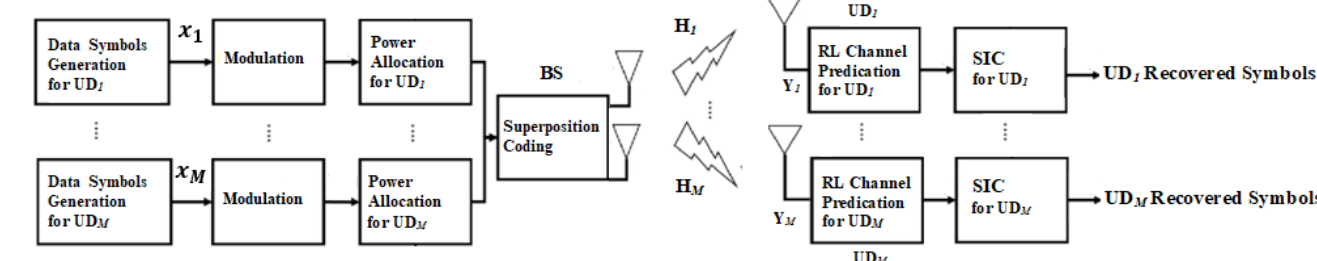
Figure 1. MISO ‐ NOMA system basic Structure based RL channel prediction. Figure 1. MISO-NOMA system basic Structure based RL channel